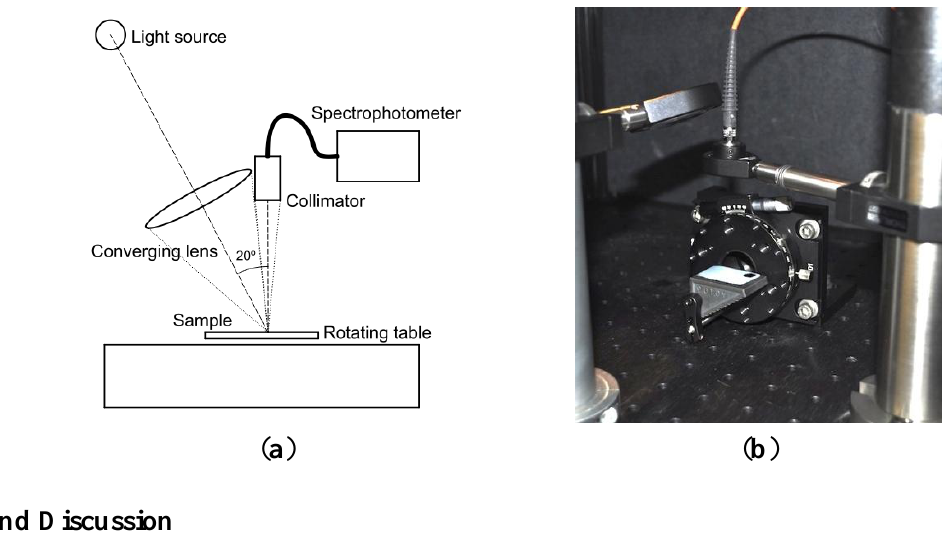
Figure 3. ( a ) Schematic and ( b ) picture of the in-house built setup used to characterize the light scattered from the beaded